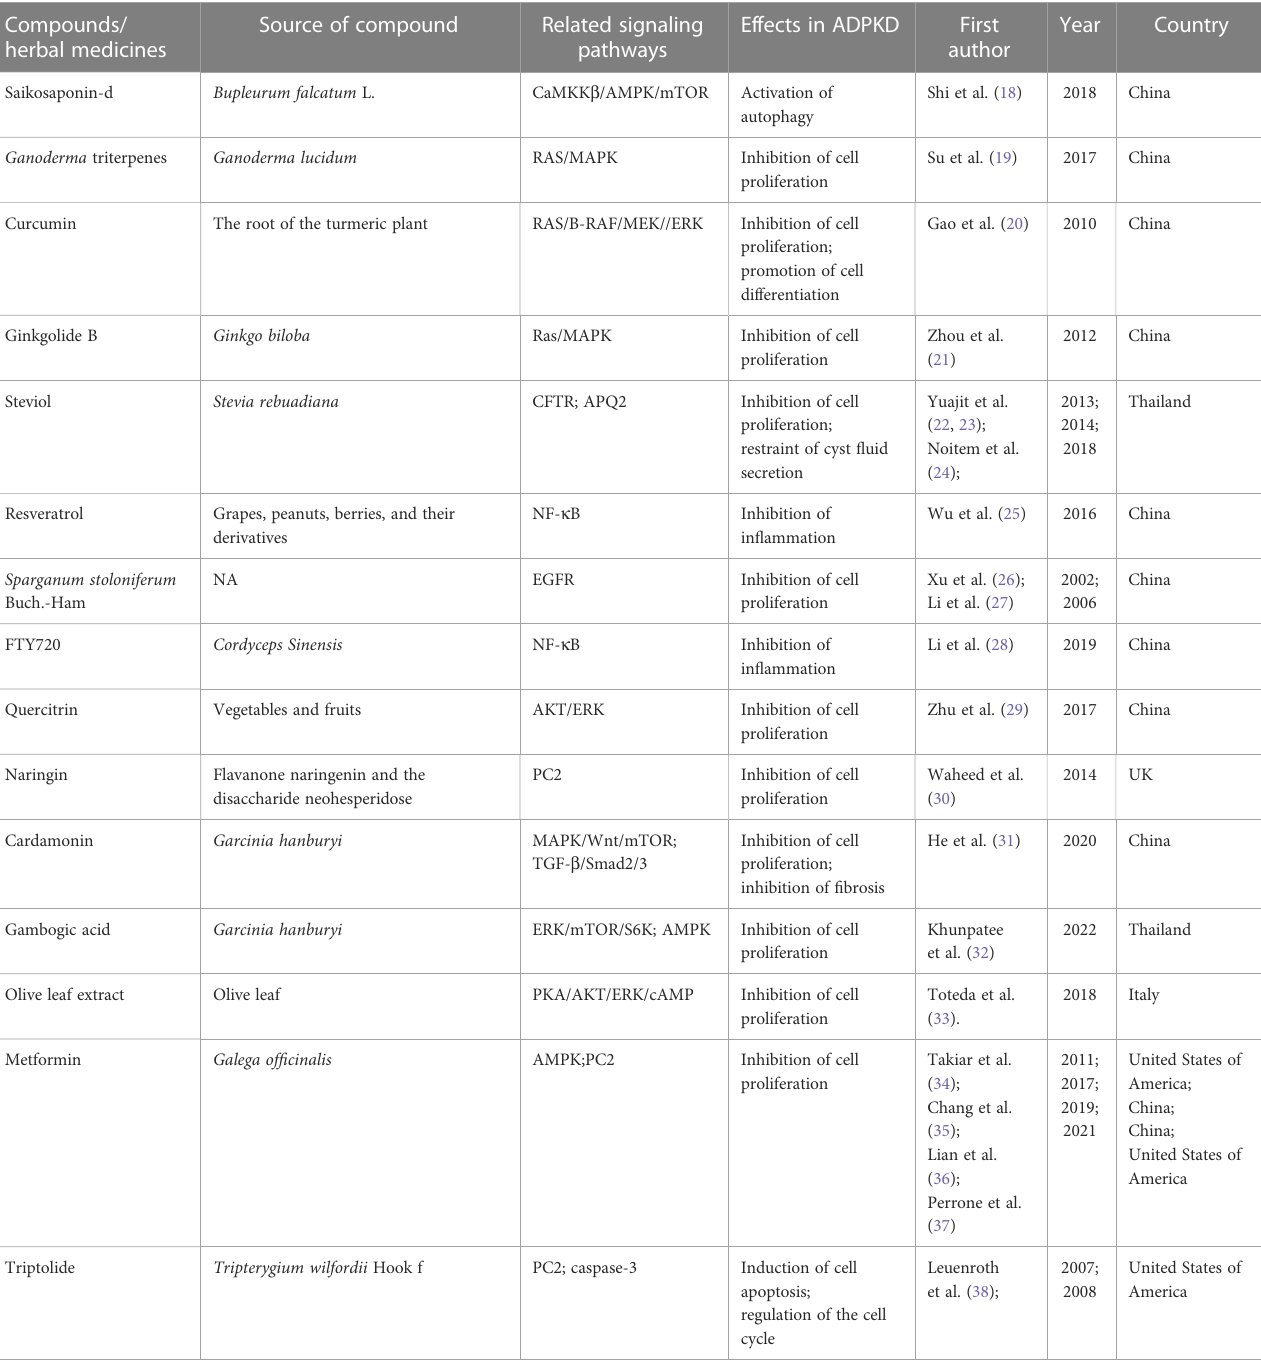
TABLE 1 Summary of the function and mechanism of plant-derived compounds in ADPKD. Compounds/ herbal